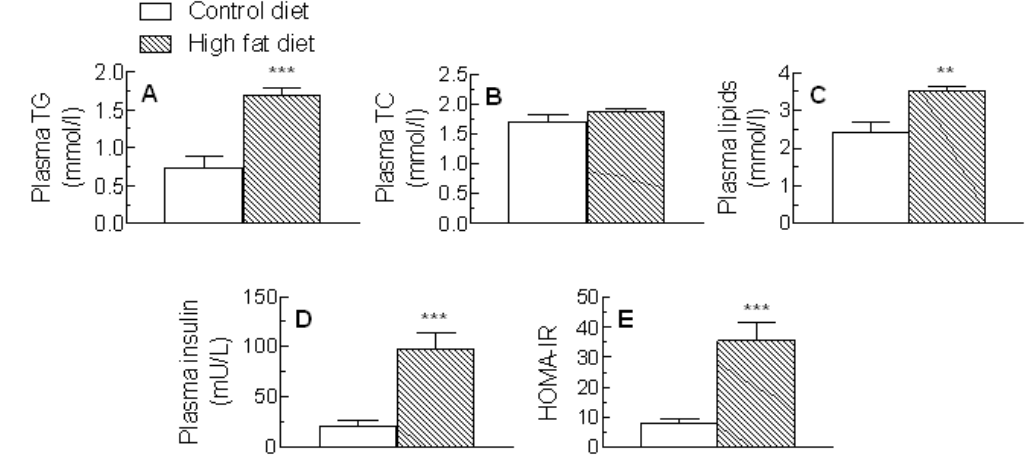
Figure 1. Rats were fed standard low fat diet (Control diet) or a high fat diet for 18 weeks. Blood samples were then collected and the concentrations of triacylglycerol (TG) ( A ) and total cholesterol (TC) ( B ), total lipids (TG + TC) ( C ) and insulin ( D ) in plasma were determined and the Homeostatic model assessment of insulin resistance (HOMA-IR) ( E ) was calculated. Data are the mean from 7 (Control diet) or 10 (High fat diet) animals and error bars show the SEM. ** P < 0.01, *** P < 0.001 vs. Control